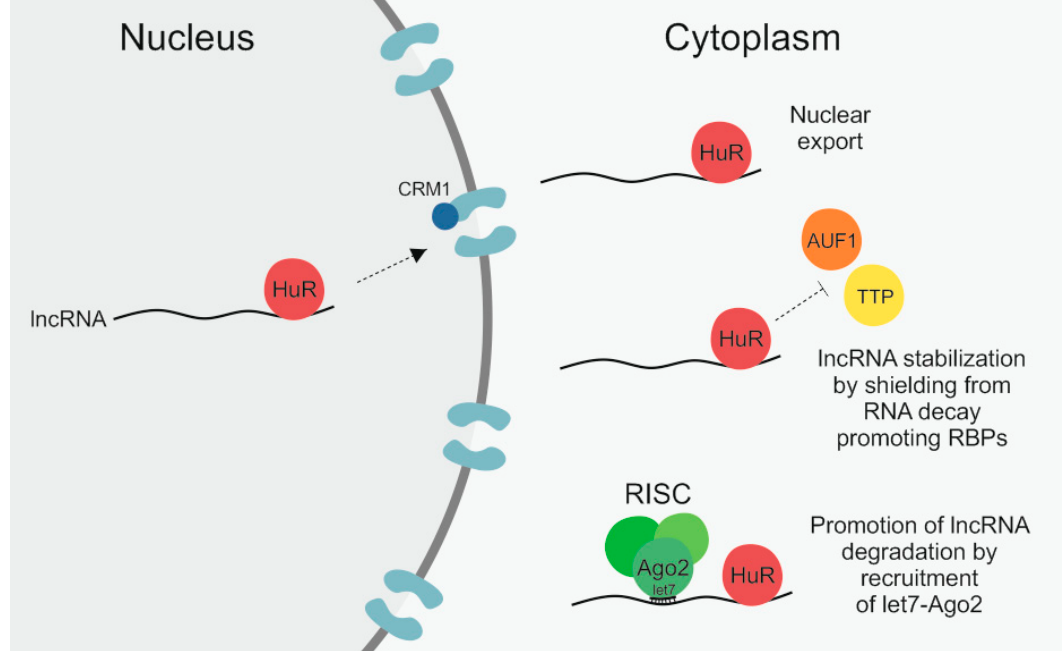
Figure 1. The RNA-binding protein (RBP) human antigen R (HuR) can regulate long non-coding RNAs (lncRNAs) by different means. First, by binding to its target lncRNA in the nucleus it can facilitate its subsequent nuclear export by interaction with the importin β superfamily member chromosomal maintenance 1 (CRM1). Secondly, by shielding lncRNAs from RNA decay promoting RBPs like ARE/poly(U)-binding/degradation factor 1 (AUF1) and tristetraprolin (TTP), HuR can enhance lncRNA stability. Thirdly, by recruitment of let7–Argonaute-2 (Ago2) it can promote lncRNA degradation via the RNA-induced silencing complex (RISC).